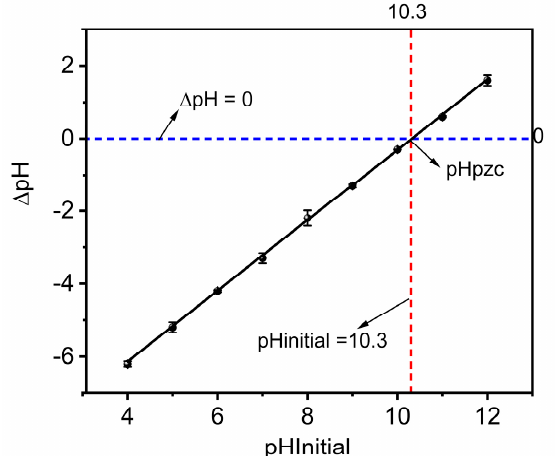
Figure 5. Point of zero charges of Douglas fir biochar treated with MgCl 2 · 6H 2 O + KOH solutions (MKB).